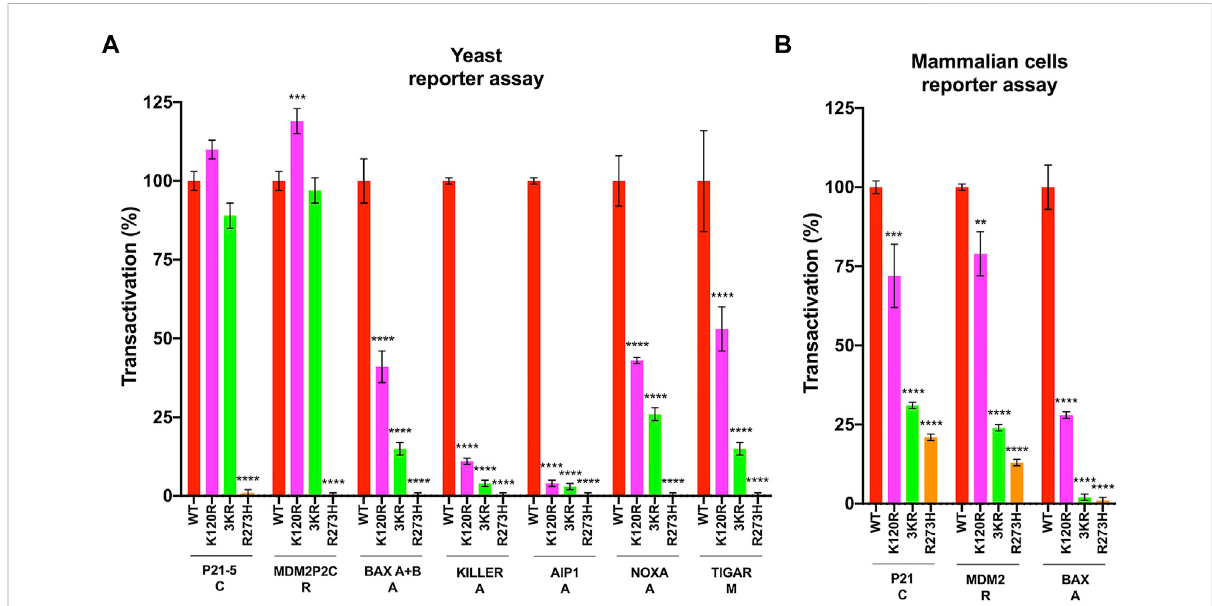
FIGURE 1 Transactivation activity of p53 WT , p53 3KR , p53 K120R , and p53 R273H proteins. (A) p53 K120R , p53 3KR , p53 R273H mutant proteins transactivation ability towards seven p53 REs with respect to p53 WT in yLFM yeaststrains. (B) p53 K120R , p53 3KR , p53 R273H mutantproteins transactivation ability towards three p53responsivepromoterswithrespecttop53 WT inHCT116 TP53 − / − cellline.Dataofreporterassaysarepresentedasmean±standarddeviation(SD)of two independent experiments with three biological replicates. The symbols **, *** and **** indicate signi fi cant differences for p = 0.0015, p ≤ 0.001 and p < 0.0001, respectively, between cells expressing p53 WT (WT) and cells expressing p53 K120R (K120R), p53 3KR (3KR) or p53 R273H (R273H). Functional classi fi cation of the gene associated with the p53 REs or promoters is indicated as following: C, cell cycle arrest; R, P53 regulation; A, apoptosis; M, metabolism.